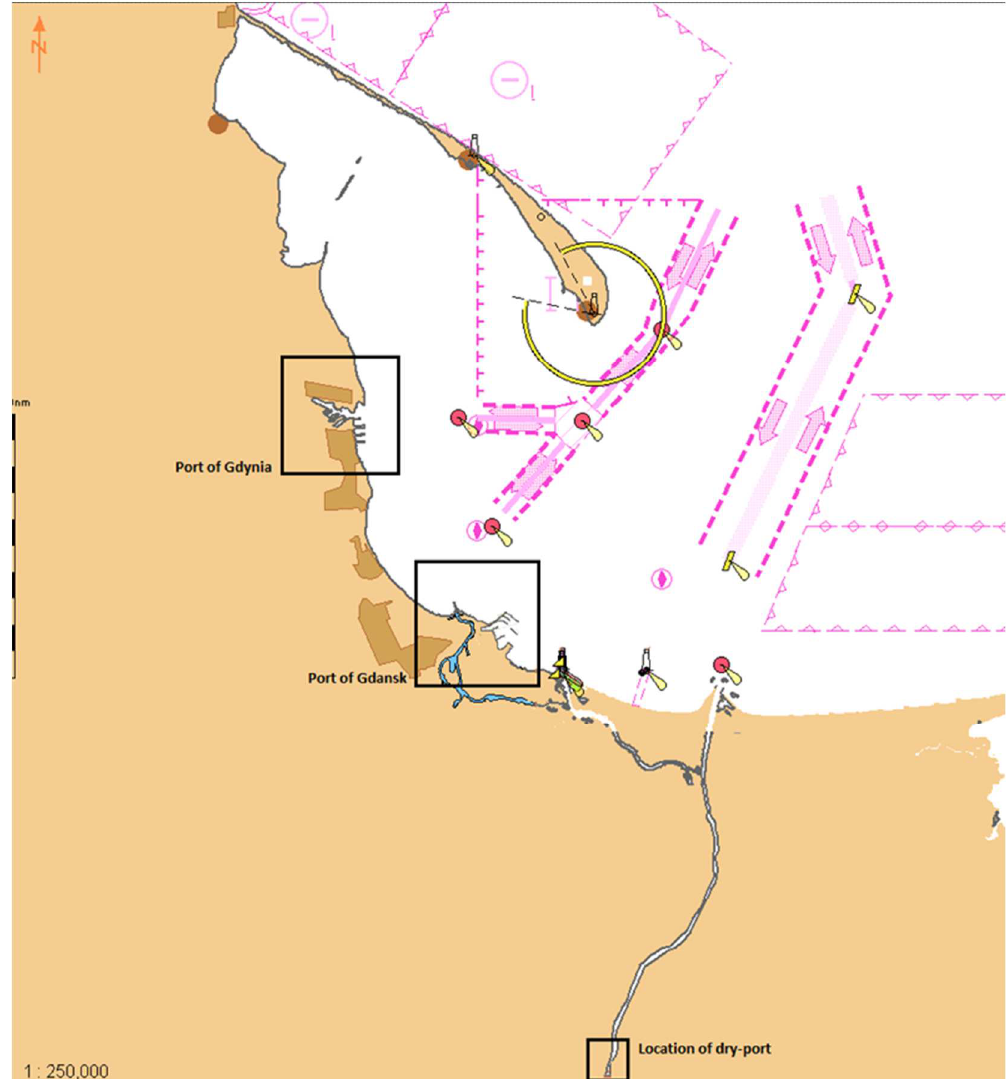
Figure 1. Gulf of Gdansk in the southern Baltic Sea with marked ports in Gdańsk, Gdynia, and a dry port in Zajączkowo Tczewskie. Source: ECDIS NaviSailor 4000.